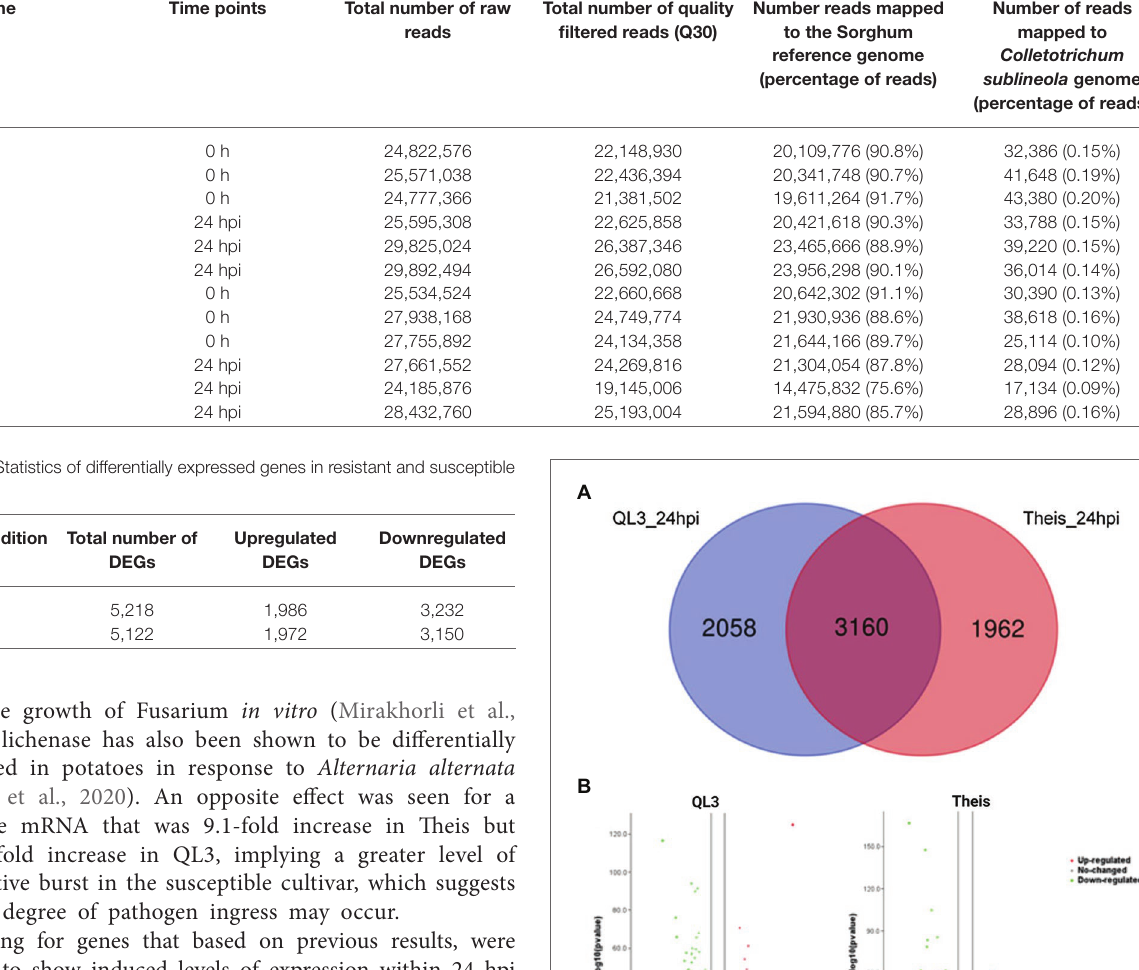
TABLE 1 | Summary of RNA Sequencing from resistant (QL3) and susceptible (Theis) sorghum cultivars infected with Johnsongrass anthracnose. Sample name